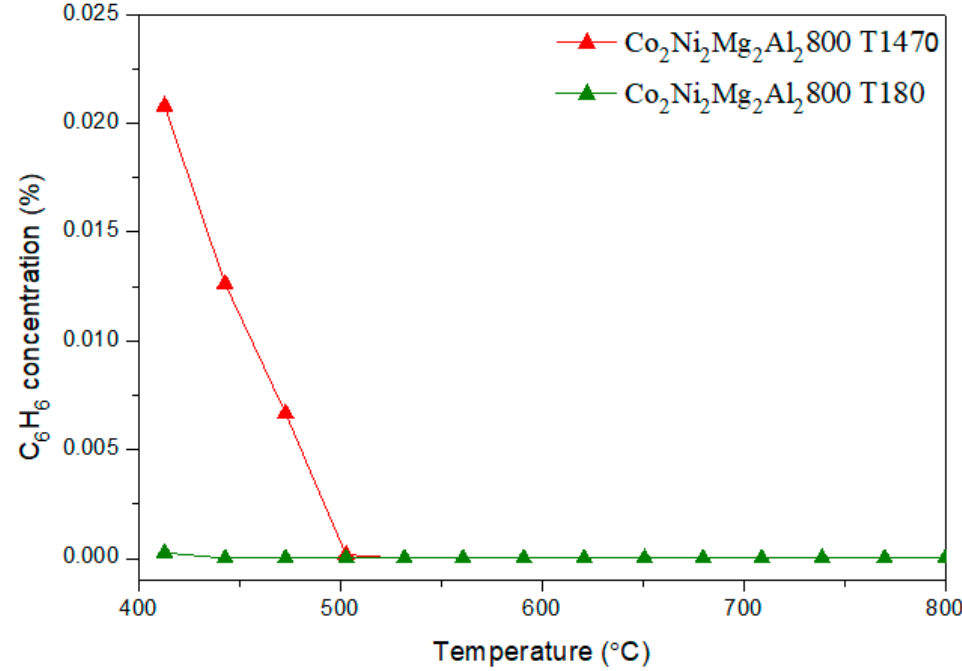
Figure 13. Evolution of benzene, in DRM, followed by MS, versus reaction temperature, on the catalyst Co 2 Ni 2 Mg 2 Al 2 800, for the toluene contents of 1470 ppm and 180 ppm.